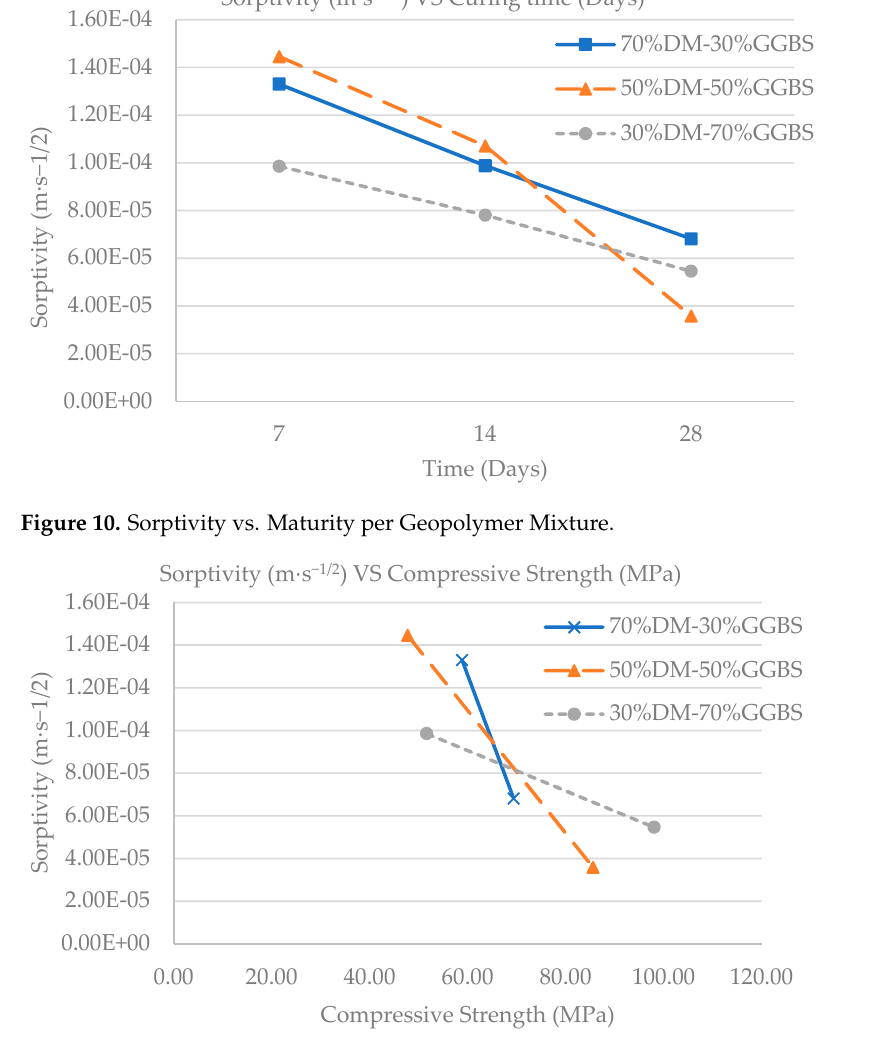
Figure 10. Sorptivity vs. Maturity per Geopolymer Mixture.